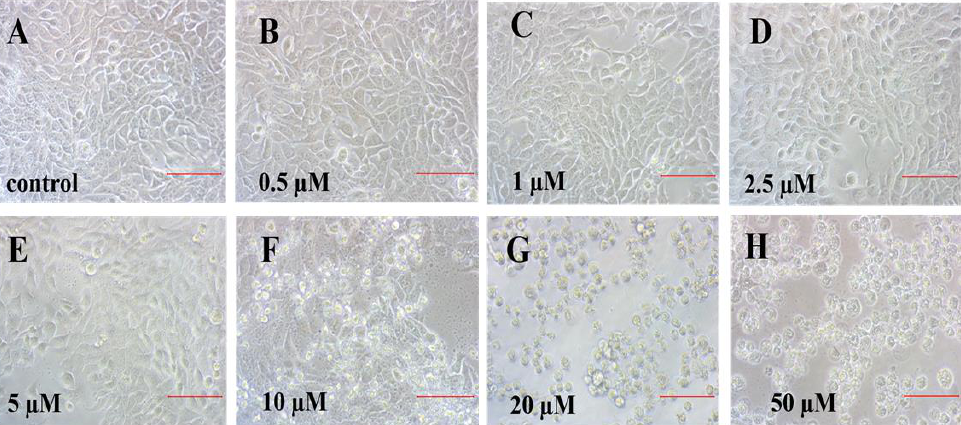
Figure 2. Morphology of HaCaT cells after exposure to Cd at 0 ( A ), 0.5 ( B ), 1 ( C ), 2.5 ( D ), 5 ( E ), 10 ( F ), 20 ( G ), and 50 ( H ) μM for 24 h. Images were recorded using inverted phase-contrast microscopy at 200× magnification (bar = 100 μm).